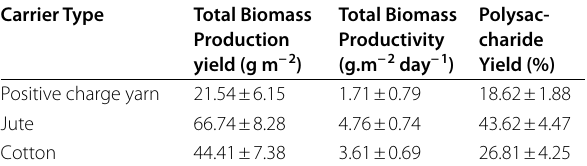
Fig. 7 ATR-FTIR spectra of Desmonostoc sp., raw yarn, jute and cotton, yarn, jute and cotton covered by Table 2 Total algal biomass production, biomass productivity and EPS yield in the different carrier’s materials after 91 days (Value presented as mean ± SD)